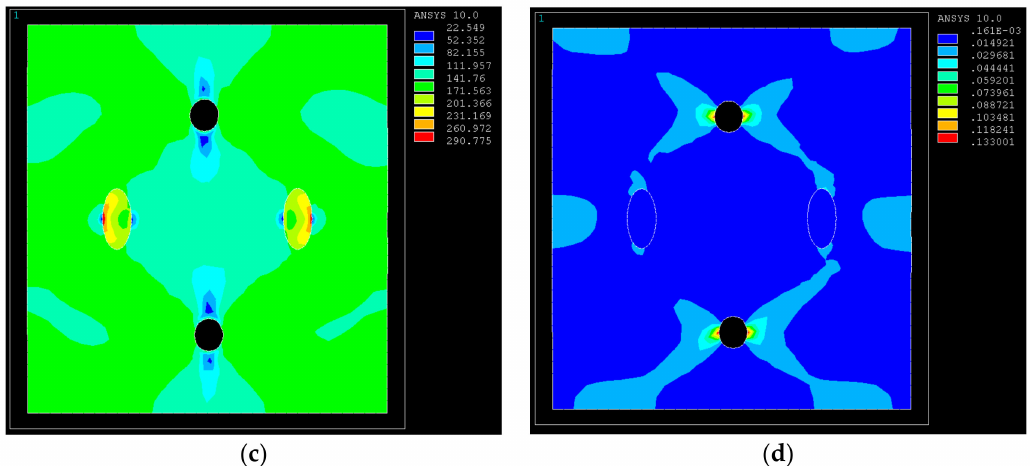
Figure 1. Stress-strain diagram of graphene reinforced aluminum nanocomposites (GRANs), ( a ) stress distribution without pore defects, ( b ) strain distribution without pore defects, and ( c ) stress distribution with pore defects, ( d ) Strain distribution with pore